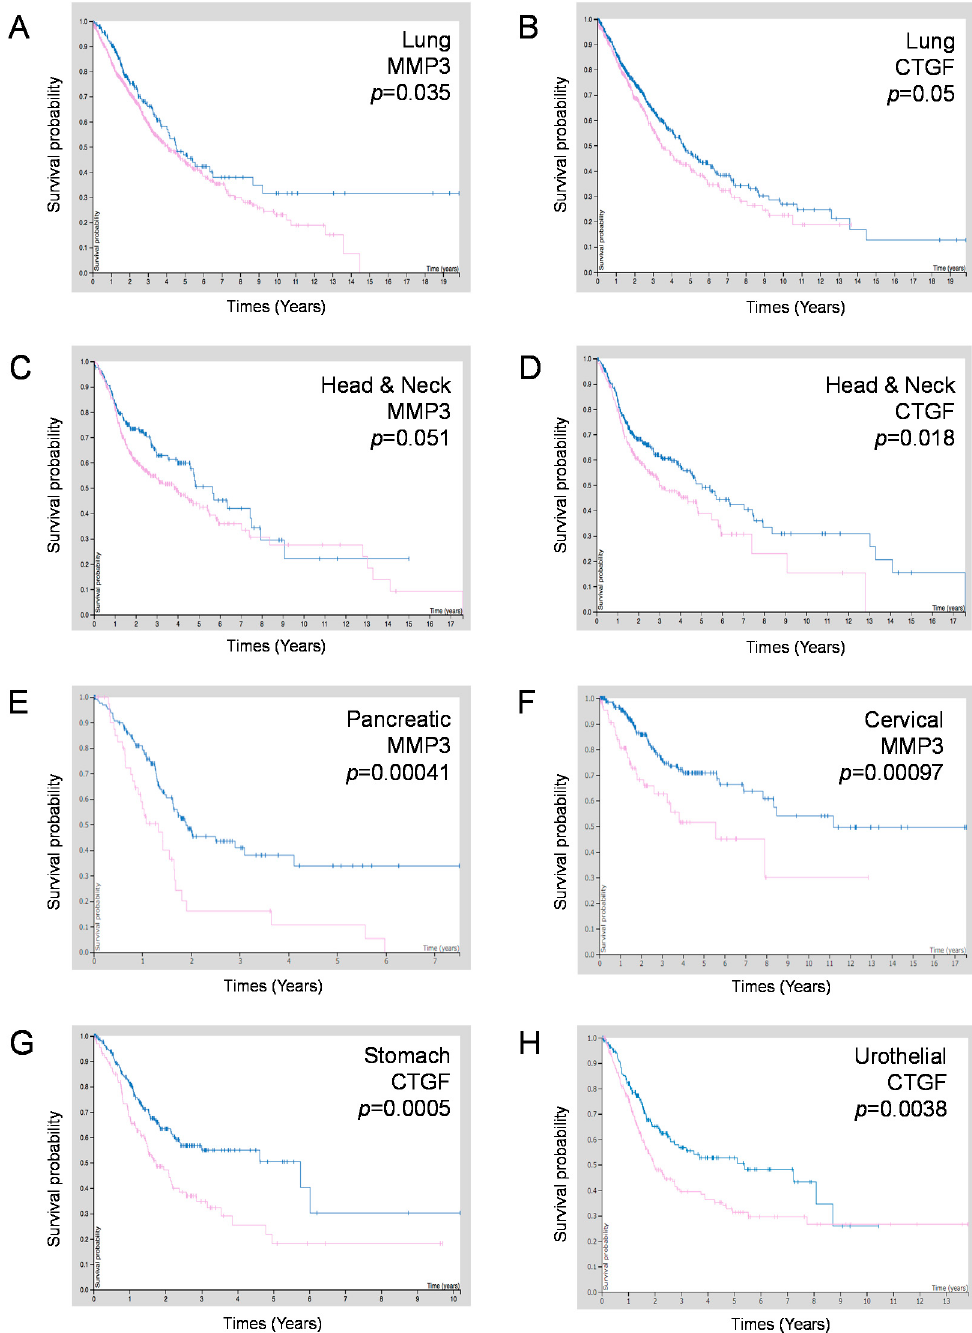
Figure 9. Kaplan–Meier survival curves of patient groups with MMP3 or CCN2 / CTGF high-expression Figure 9. (purple line) vs. low-expression (blue line). ( A , B ) Head and neck cancer cases. ( C , D ) lung cancer cases. ( E , F ) Comparison between MMP3-high vs. -low expression groups in ( E ) pancreatic cancer cases and ( F ) cervical cancer cases. ( G , H ) Comparison between CCN2 / CTGF-high vs. -low expression groups in ( G ) stomach cancer cases and ( H ) urothelial cancer cases. Data were obtained from TCGA and Human Protein Atlas